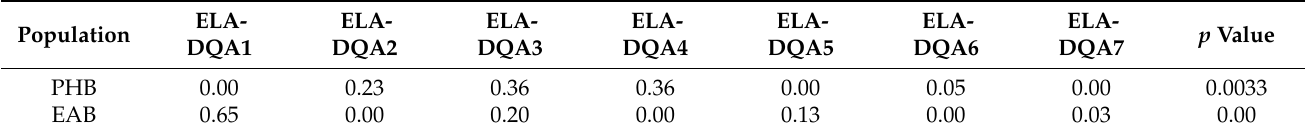
Table 2. The allelle frequencies for two populations of Przewalski’s horse.